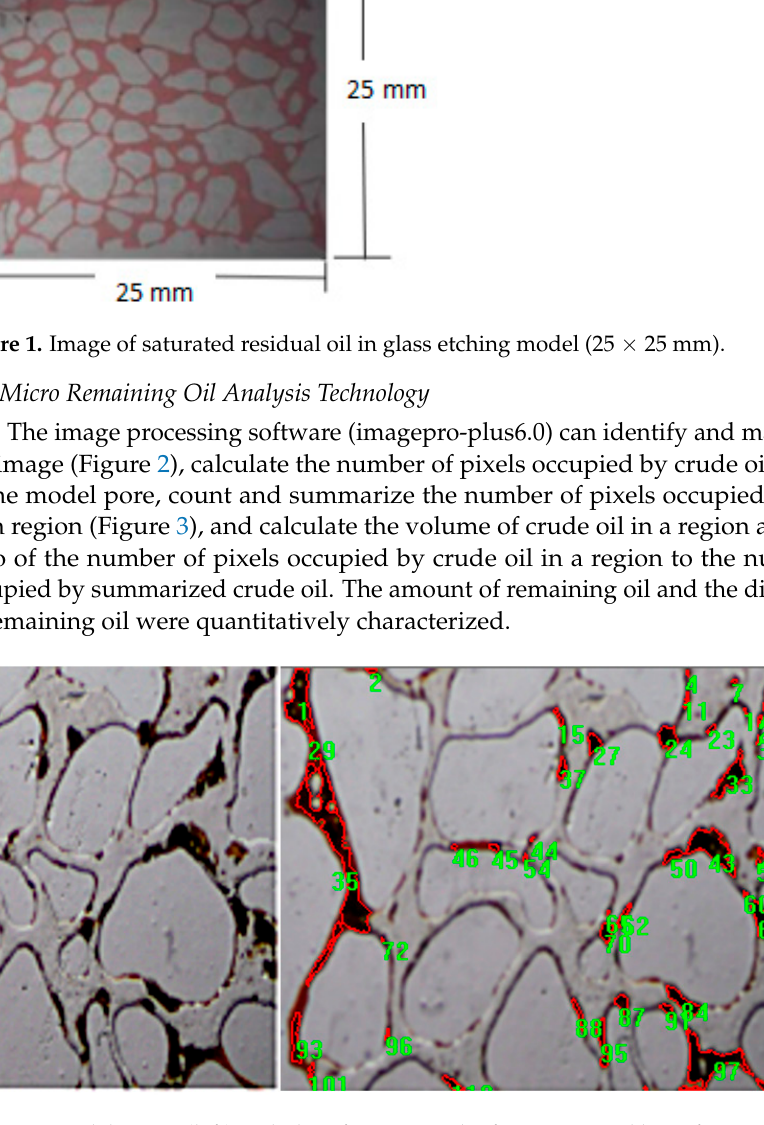
Figure 2. Model image (left) and identification mark of remaining oil by software (right).